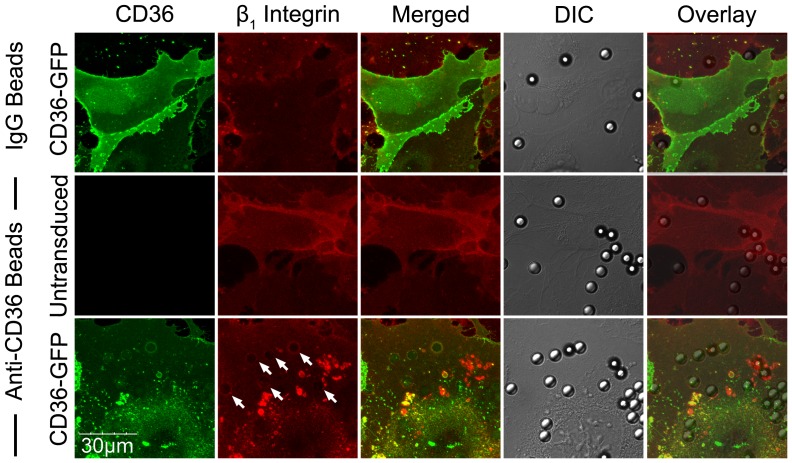
β1 integrin recruitment by adherent anti-CD36 coated beads on HMEC-1.HMEC-1 monolayers in ibidi chambers transduced with GFP-CD36 were incubated with beads coated with IgG1 or anti-CD36 for 30 min at 37°C in 5% CO2. The slides were fixed and stained as described in Figure 7 using a PE-labelled anti-β1 integrin mAb. Results shown are representative of 3 independent experiments.